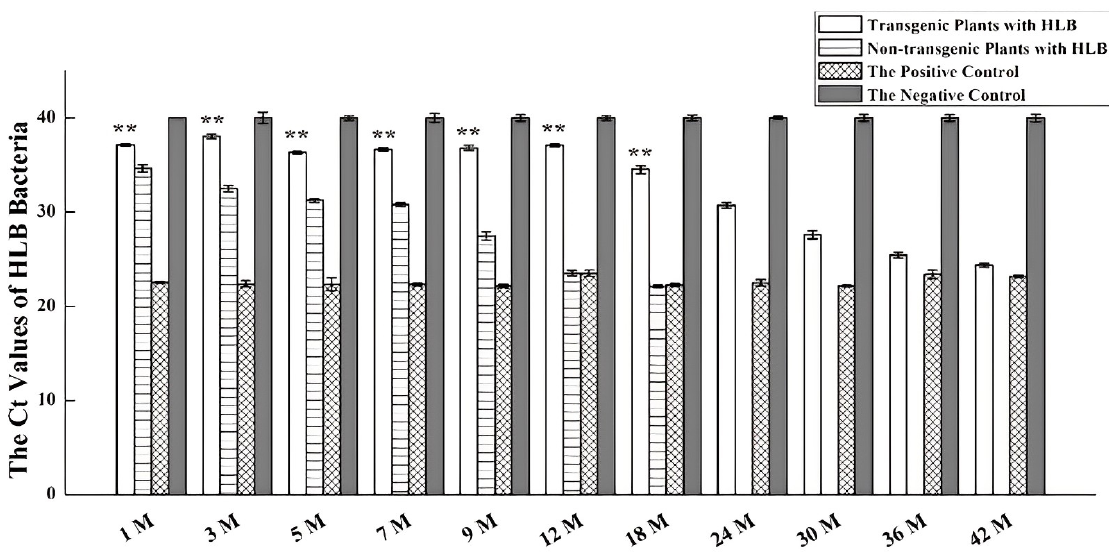
Figure 2. Quantitative real-time PCR detection of HLB in transgenic plants overexpressing miR171b. The horizontal axis represents detection time points following the inoculation of HLB. The vertical axis represents Ct values of the HLB-specific amplicon. Experiments were repeated twice with similar results. ** indicates p values of <0.01 compared with the non-transgenic plants. The M on the X -axis means the month.